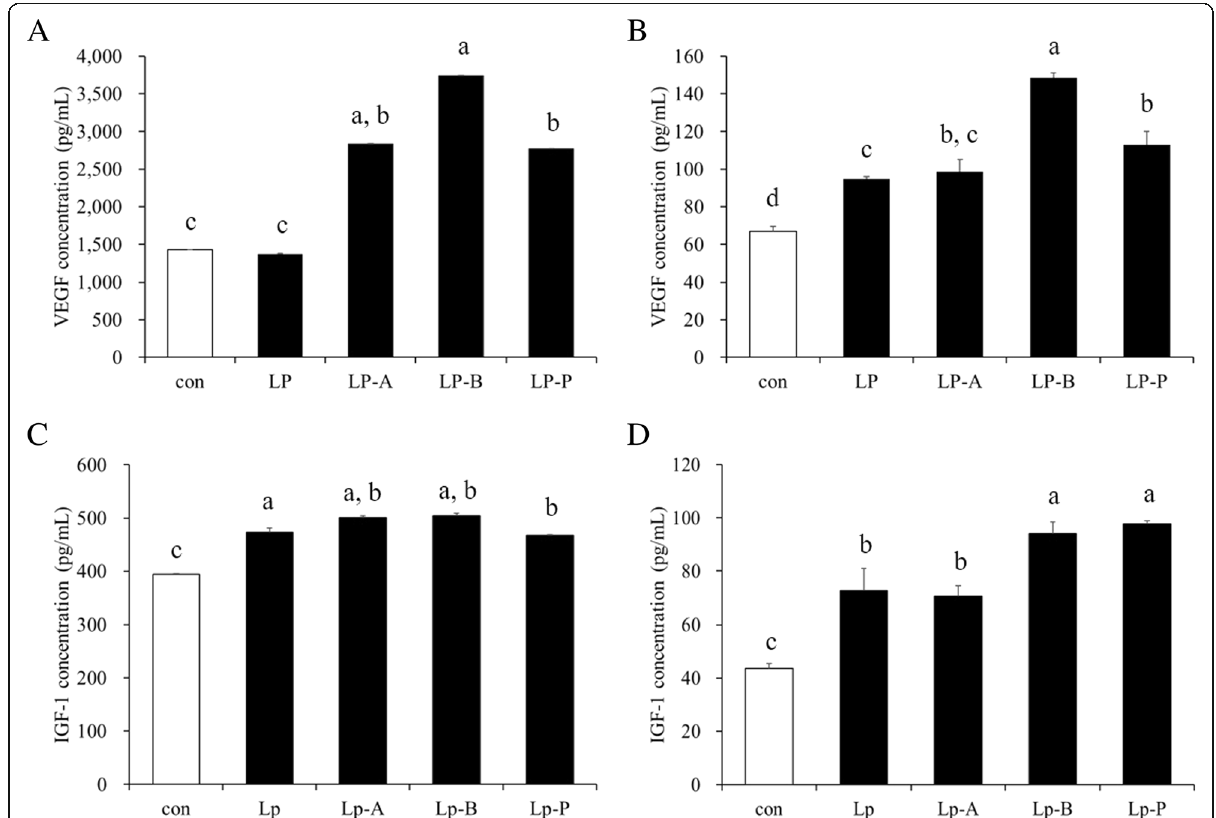
Fig. 3 The effect of the concentration of vascular endothelial growth factor (VEGF) and insulin-like growth factor 1(IGF-1) on L. plantarum and on L. plantarum hydrolysates of MG-63 osteoblastic cell ( a , c ) and human dermal papilla cell (hDPC) ( b , d ). Data are expressed as a percentage of the control result. The control (con) group was not a treated sample, hydrolysates of L. plantarum (LP), hydrolysates of L. plantarum by Alcalase (LP-A), hydrolysates of L. plantarum by bromelain (LP-B), and hydrolysates of L. plantarum by Protamex (LP-P). All values are expressed as means ±S.D. ( n =3). The letters a, b, c, and d above the bars stand for significantly different ( p <0.05) groups by one-way ANOVA, followed by Duncan ’ s multiple